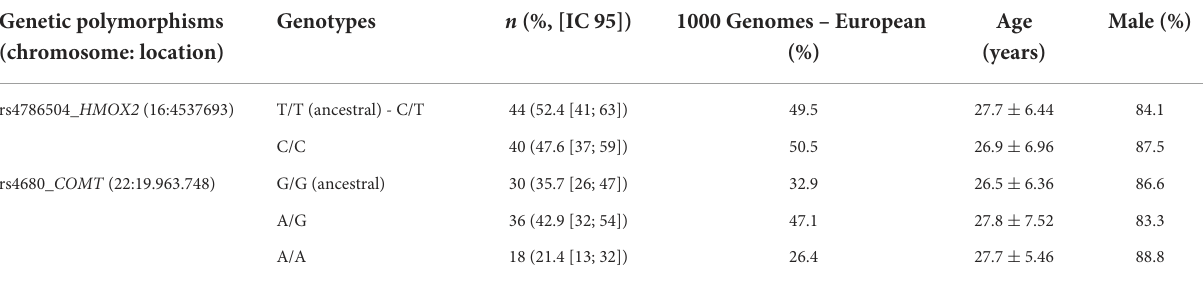
TABLE 1 Genetic distribution of HMOX2 and COMT polymorphisms in our population and in the data base of 1000 genomes. Genetic